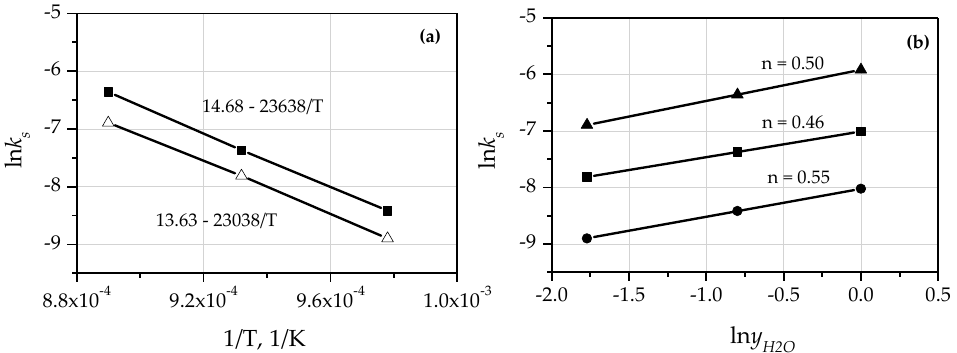
Figure 7. ( a ) Determination of the Arrhenius parameters and ( b ) the reaction order with respect to the molar fraction of steam for the volumetric model (VM) rate equation. Symbol markings as in Figure 6.